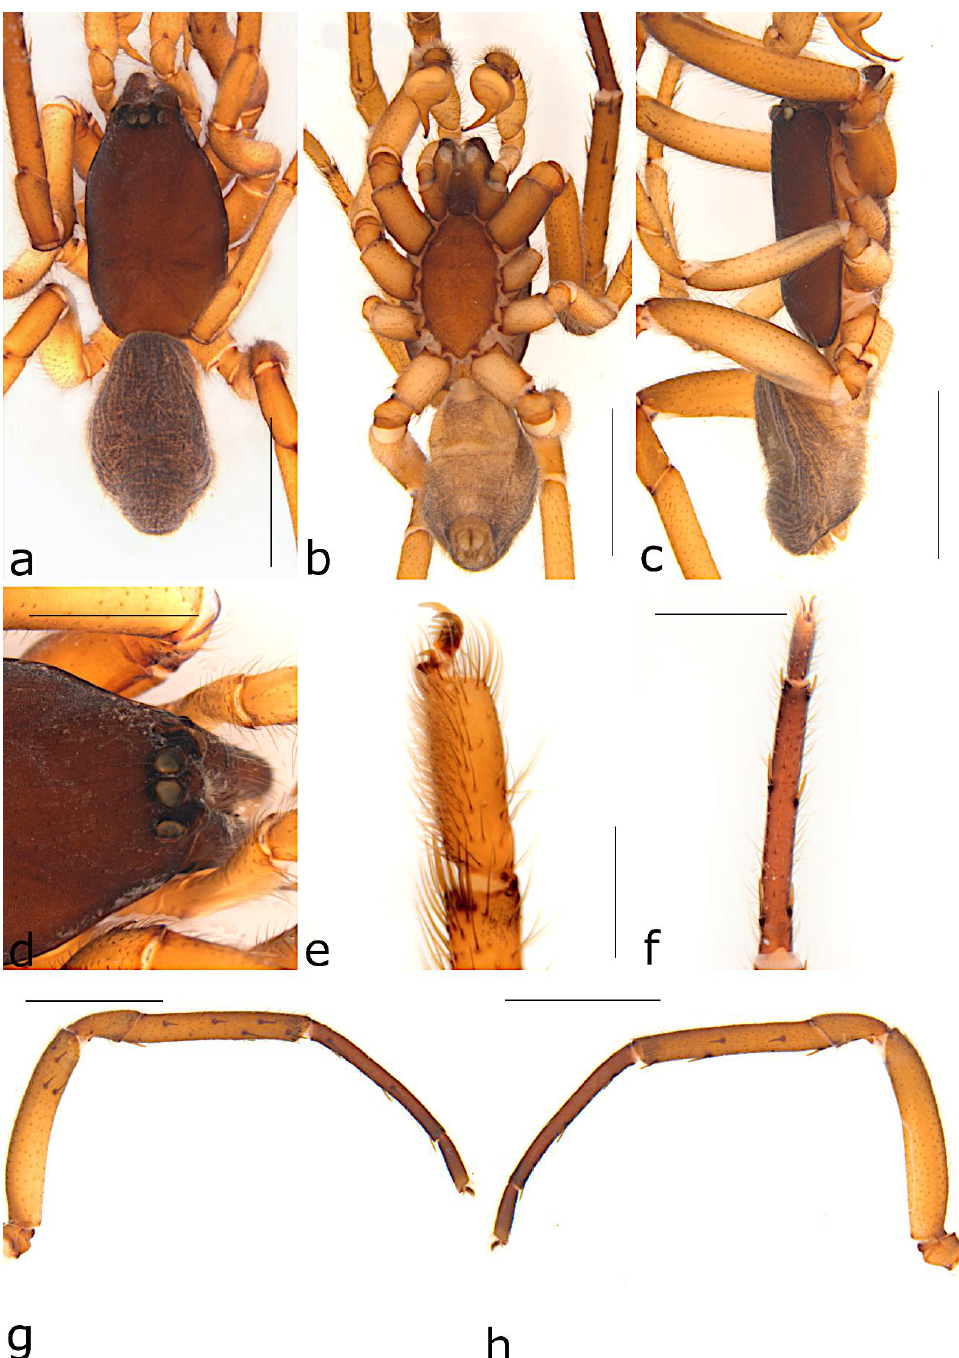
Figure 20. Ariadna tria sp. nov. ♂ holotype (MV K-14905) from French Island (Vic): ( a ) habitus, dorsal view; ( b ) same, ventral view; ( c ) samIlateral view; ( d ) eyes, dorsal view; ( e ) left metatarsus IV, preening comb, retrolateral view; ( f ) left leg I, ventral view; ( g ) same, prolateral view; ( h ) same, retrolateral Iw. Scale bars ( a – c ) = 2 mm, ( d ) = 1 mm, ( e ) = 0.5 mm, ( f ) = 1 mm and ( g , h ) = 2 mm.